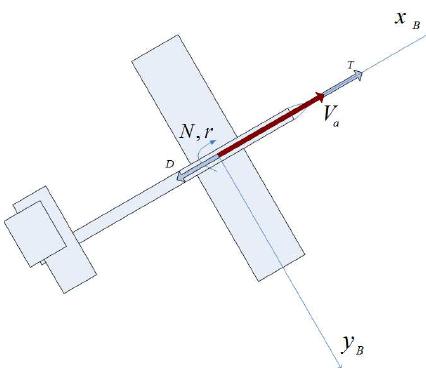
Figure 2: Forces and moments acting on the airplane when con- sidering v << 1 .